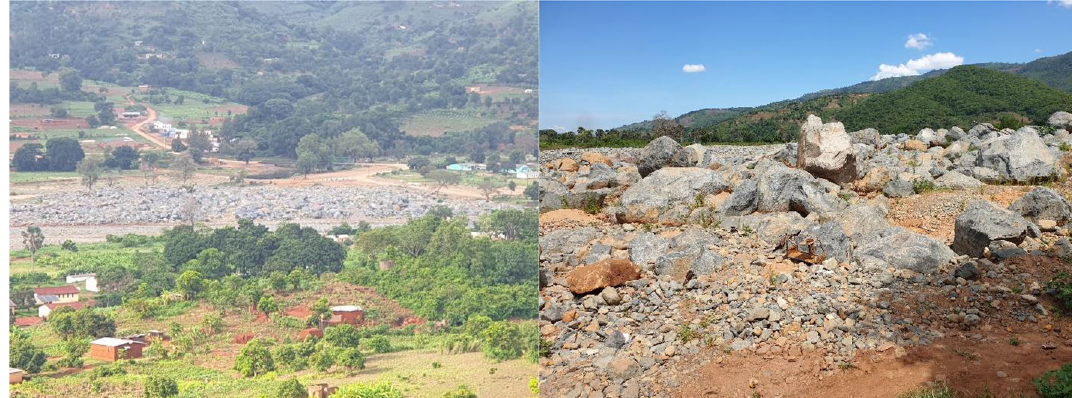
Fig. 2 The impacts of Cyclone Idai at Kopa Growth Point, Chiman- imani District, Zimbabwe. Elevated view of the once built up Kopa settlement now replaced by boulders (left) and zoomed in image